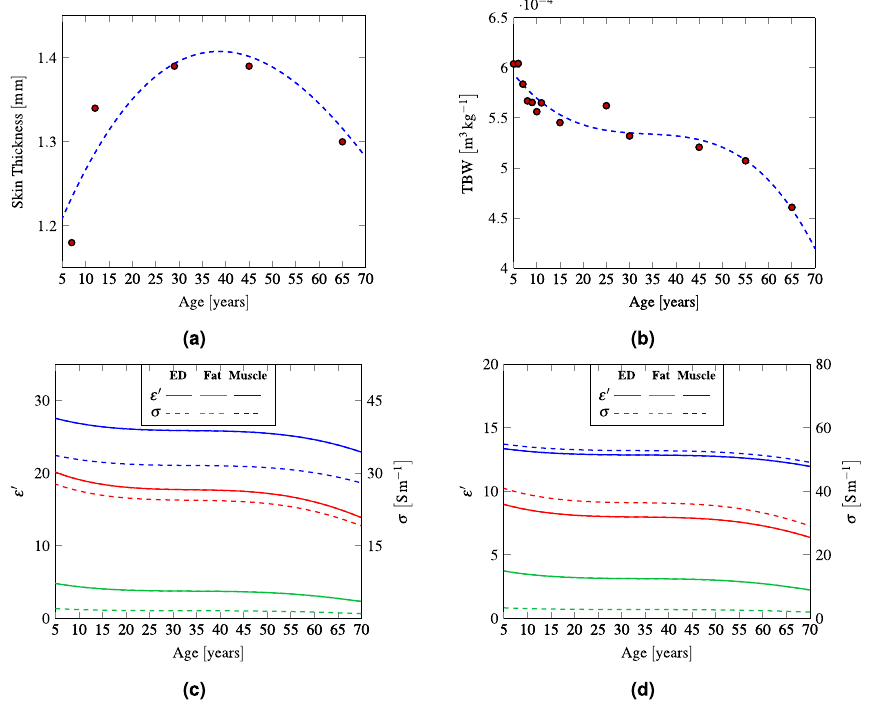
Figure 2. ( a ) Forearm skin thickness 23,30 ( b ) TBW data 35,36 , permittivity ε ′ , and conductivity σ as a function of age ( c ) at 26 GHz and ( d ) at 60